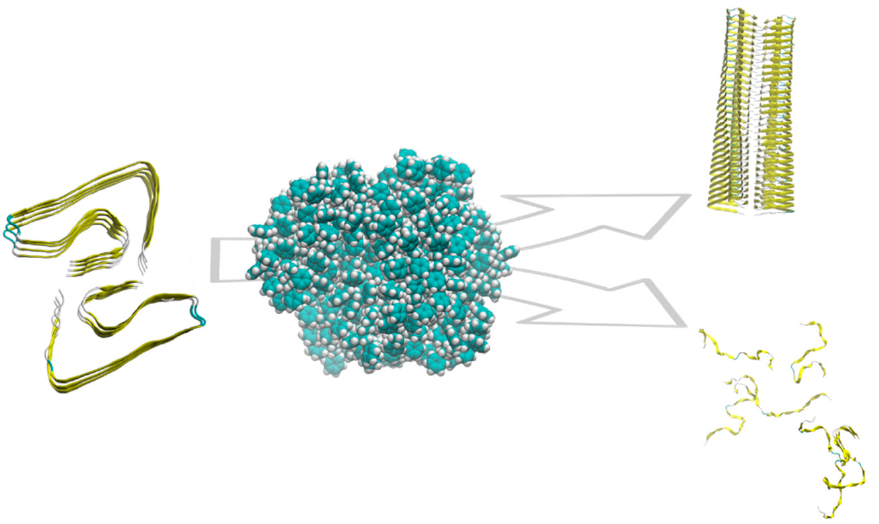
Figure 1. Schematic of the role of polystyrene NP on amyloid aggregation. Depending on the features of the NP and the protein/NP ratio, the aggregation is promoted or inhibited.